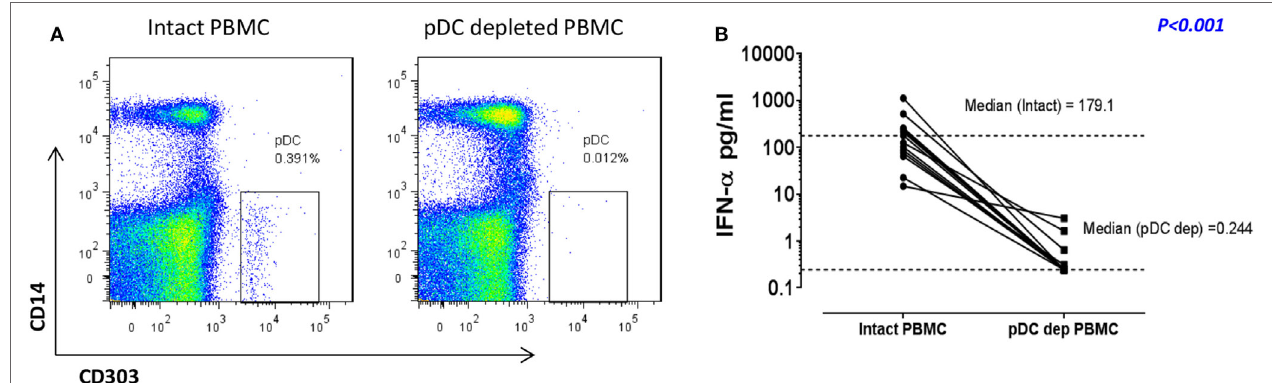
FigUre 1 | In response to human rhinoviruses strain 16 (RV16) stimulation, plasmacytoid dendritic cell (pDC)-depleted peripheral blood mononuclear cells (PBMCs) produce significantly less interferon (IFN)- α than intact PBMC. PBMC were either depleted of pDC using CD303 immunomagnetic beads or left intact. Efficiency of pDC depletion was examined with flow cytometry (a) . PBMC (5 × 10 5 cells/well) were then cultured in the presence/absence of RV16 (MOI = 1) for 24 h at 37°C. IFN- α production in culture supernatant was measured by enzyme-linked immunosorbent assay (ELISA). Data shown are for the net RV16 simulated IFN- α concentration following subtraction of the IFN- α concentration in the absence of RV16 (media control). The dotted lines represent the median of each group ( n = 15). IFN- α concentrations in pDC-depleted PBMC were significantly lower than intact PBMC ( p < 0.001) (B)